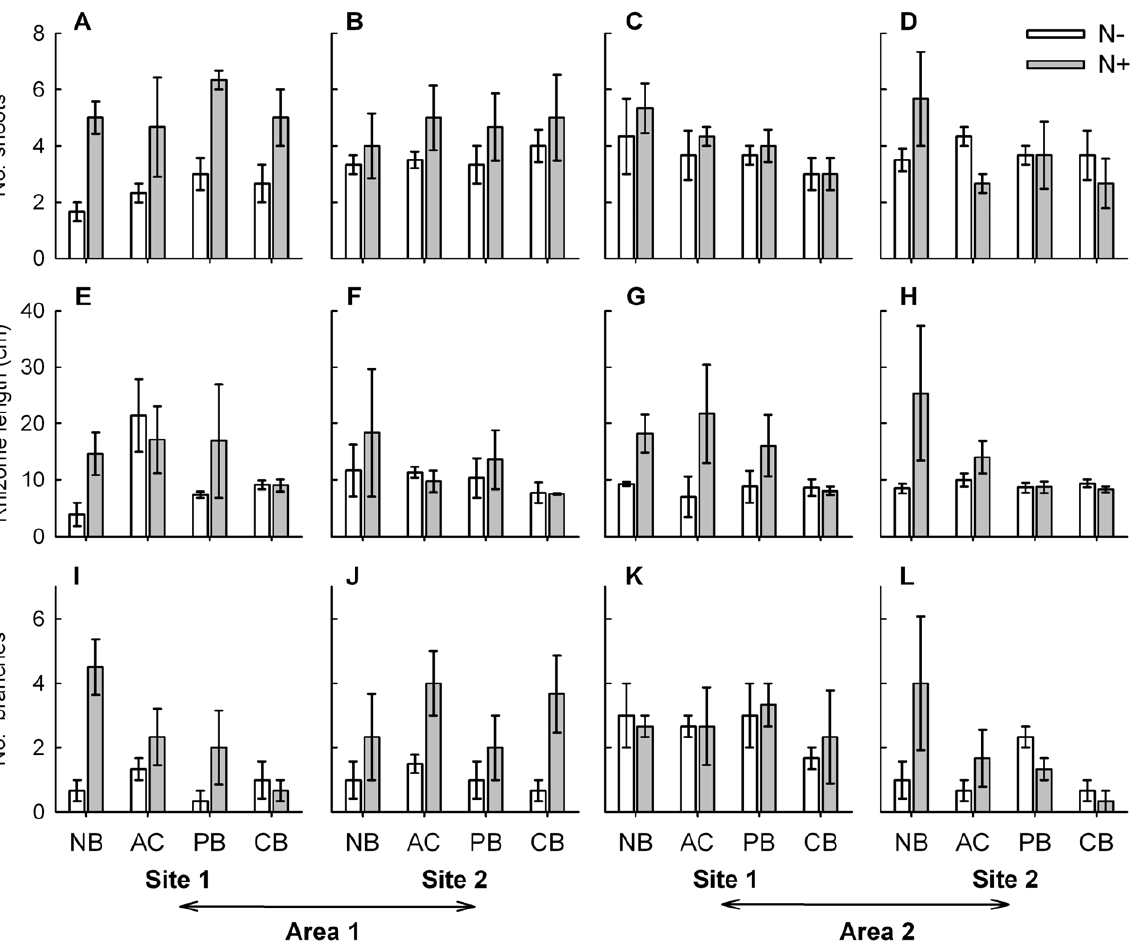
Figure 3. Morphological variables of Sporobolusvirginicus clones subjected to different experimental treatments . Mean ( 6 1 SE) number of shoots (A, B, C, D), rhizome length (E, F, G, H) and number of branches (I, J, K, L) of plants grown in the two sites within each of the two areas. N 2 = no nutrient added, N + = nutrient addition; NB = no burial, AC = artifact control, PB = partial burial, CB = complete burial. n=3.